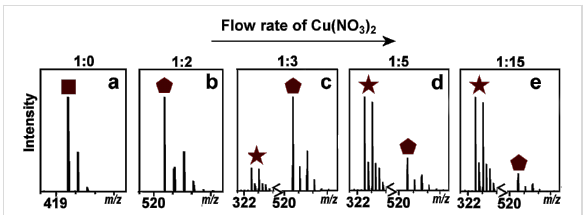
Figure 3: ESI-MS isotope patterns of ttop + Na (square), m / z 419.2, [Cu(C 24 H 24 N 6 )(NO 3 )] + ( 1 , pentagon), m / z 521.1, and [Cu 2 (C 24 H 24 N 6 )(NO 3 ) 2 ] 2+ ( 3 , star), m / z 323.0, showing how an increase in flow rate from the pump containing Cu(NO 3 ) 2 ·6H 2